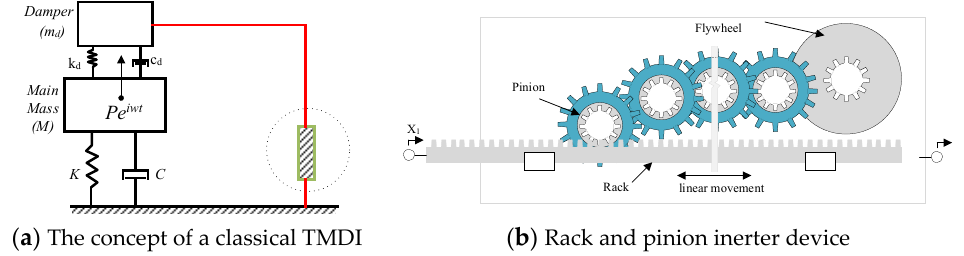
Figure 2. Schematic drawing of TMDI.